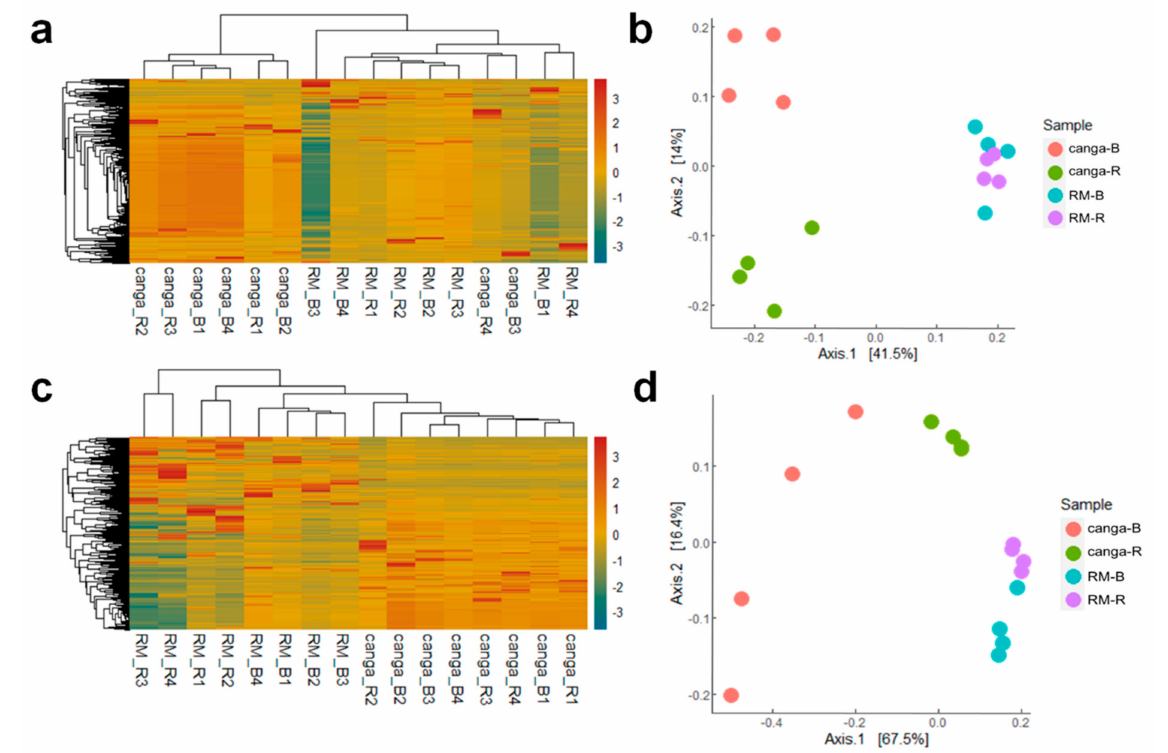
Figure 4. Heatmap and principal coordinate analysis for cumulative sum scaling (CSS)-normalized counts of the fungal 18S rRNA and bacterial 16S rRNA gene sequences obtained from substrates from D. apurensis growing in canga or rehabilitating minelands (RM). canga_B and RM_B, bulk substrate; canga _R and RM_R, rhizospheric substrate. ( a , b ) Heatmap showing differences between fungal 18S rRNA ( a ) and principal coordinate analysis for cumulative sum scaling of fungal 18S rRNA ( b ). ( c , d ) Heatmap showing differences between bacterial 16S rRNA ( c ) and principal coordinate analysis for cumulative sum scaling of bacterial 16S rRNA ( d